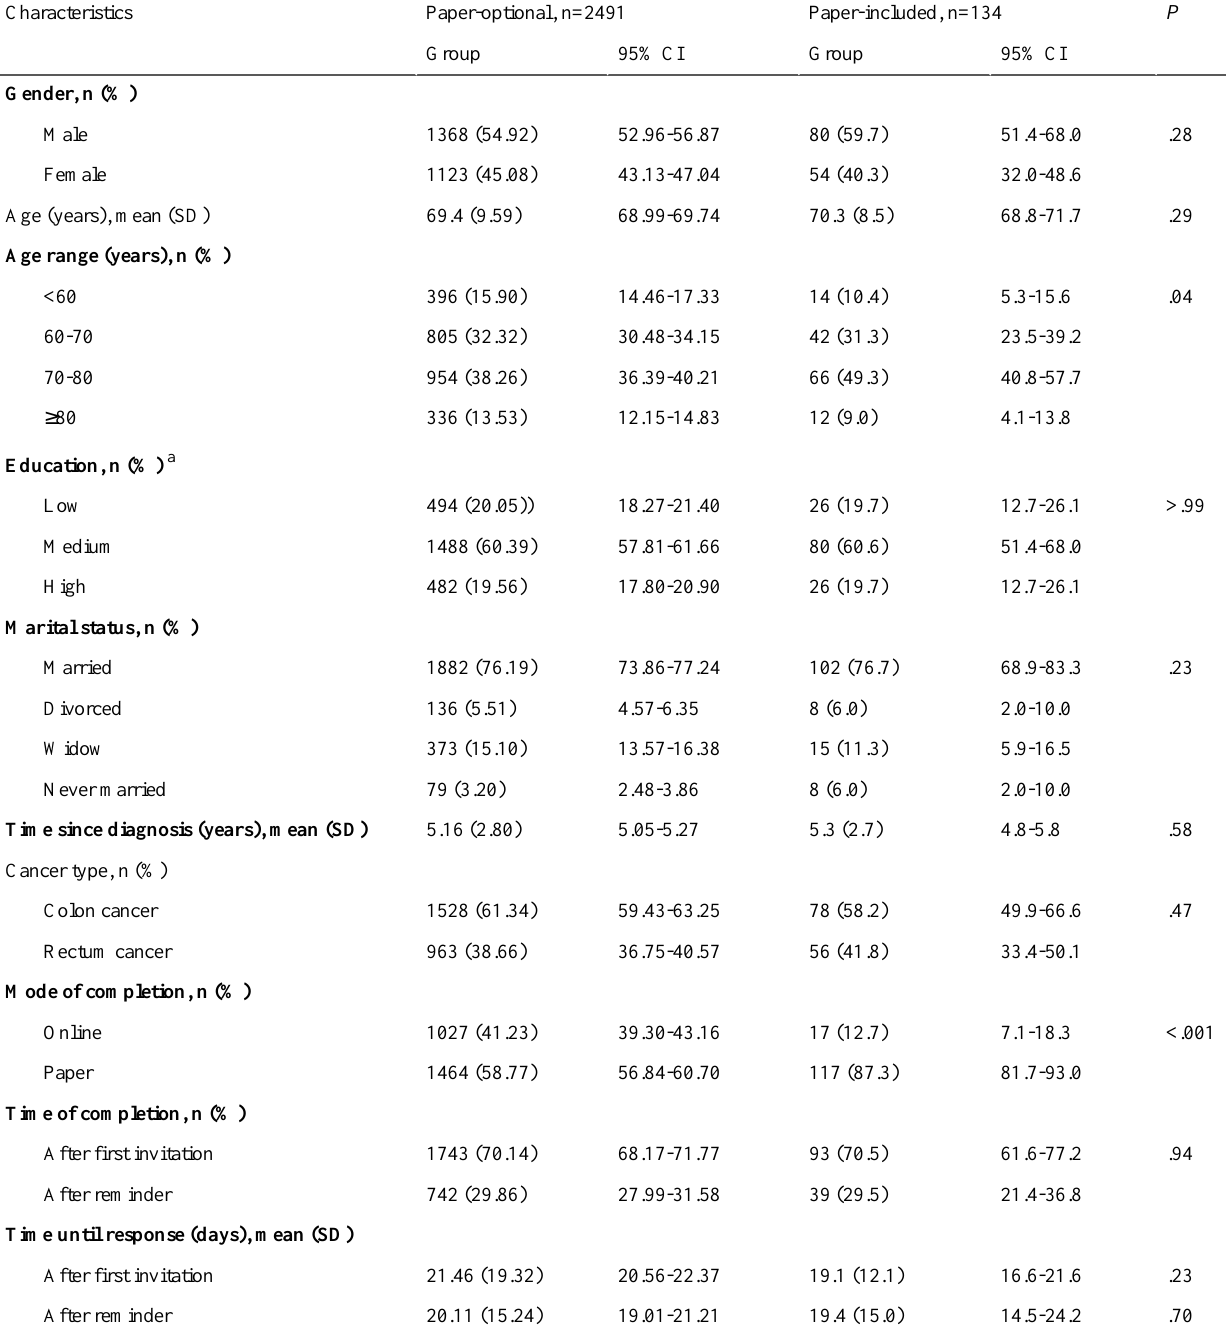
Table 2. Demographic and clinical characteristics of colorectal cancer patients in the paper-optional and the paper-included groups.